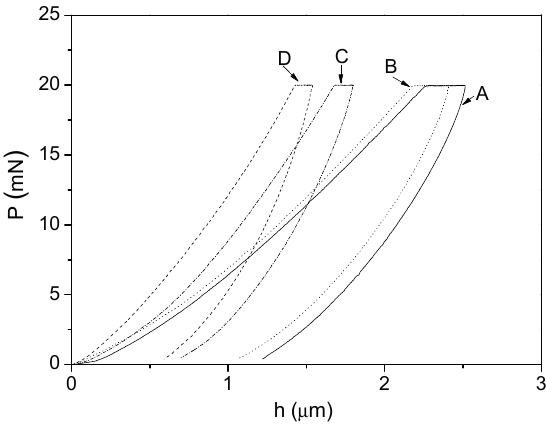
Figure 3. Load-displacement curves of GNS-based epoxy resin coating with different